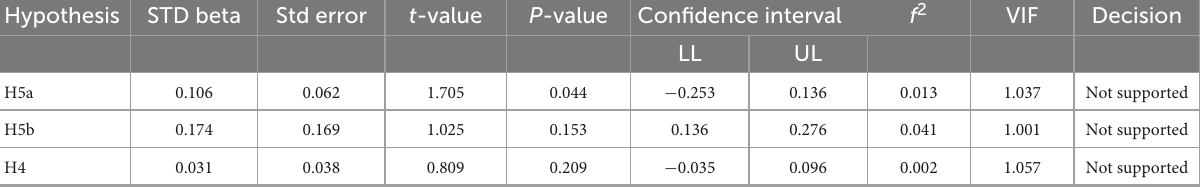
TABLE 9 Results of the structural model analysis (moderation).